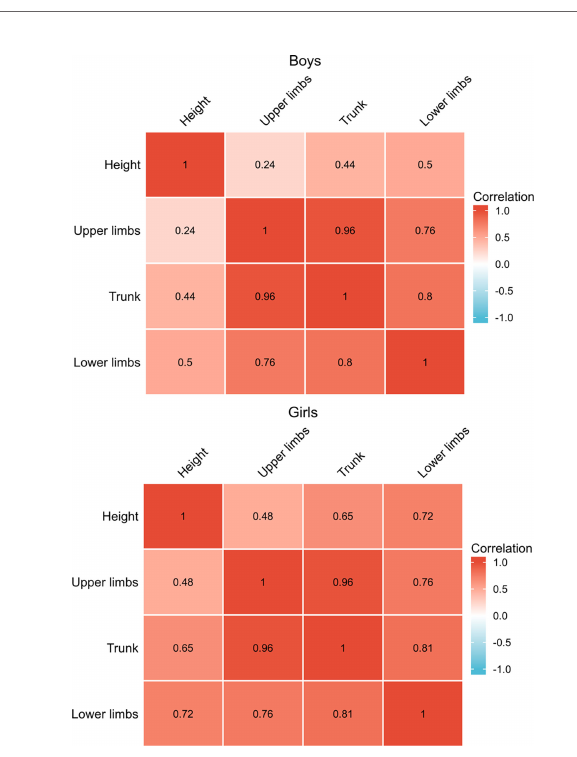
FIGURE 5 | Correlation between changes of SMM, BFM, and annual height gain in different nutritional statuses. *Signi fi cant difference to the BFM dominant group ( p < 0.05).